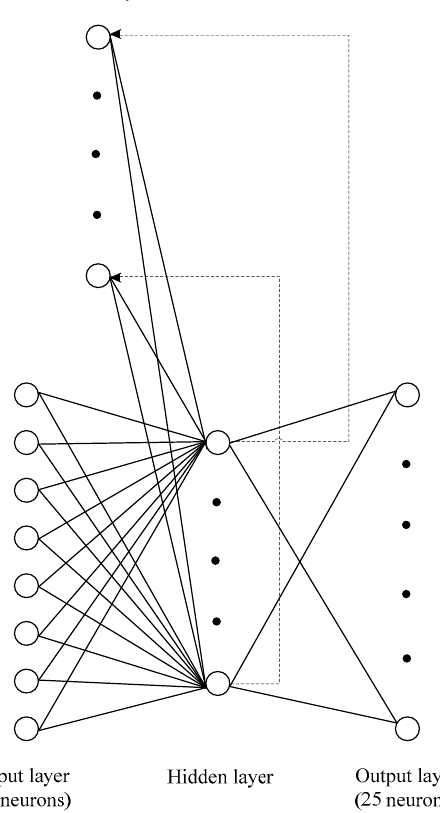
Figure 1. Elman neural network sub-pixel urban inundation mapping (ENN-SUIM) architecture (scale = 5).